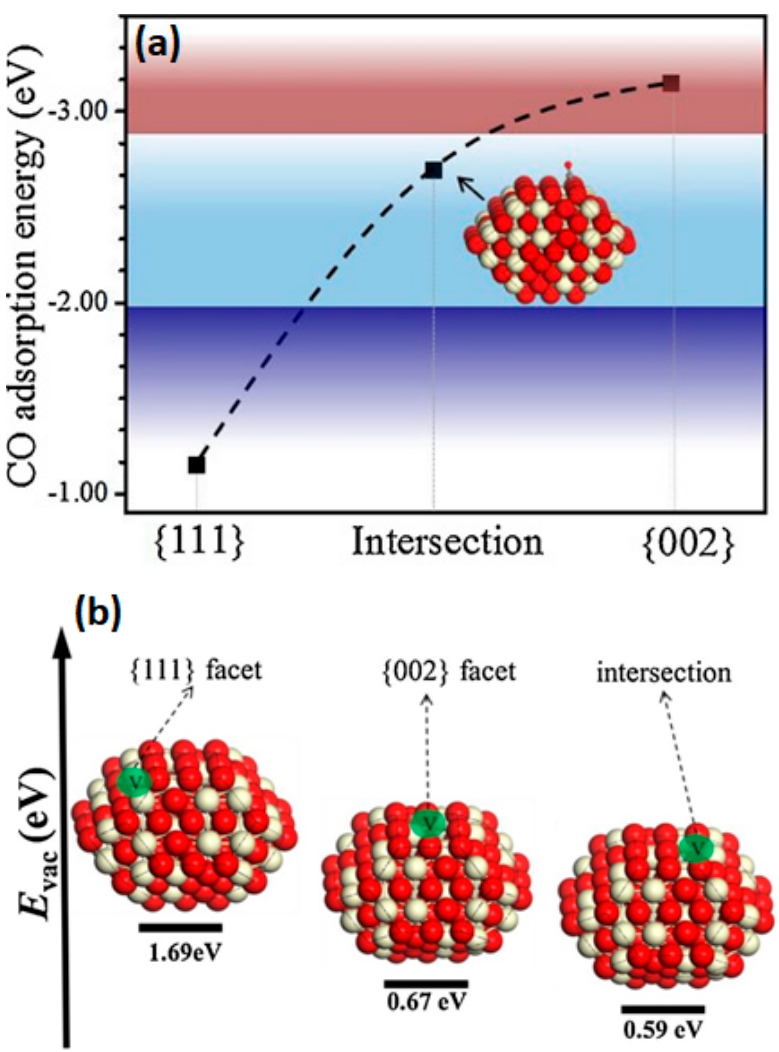
Figure 18. ( a ) DFT-calculated adsorption energy for molecularly adsorbed CO on {111}, {002} facets and their intersection sites of a Ce 60 O 120 cluster obtained, ( b ) Models of the optimized geometries of Ce 60 O 119 with an oxygen vacancy in the highlighted positions: {111}, {002} facets and their intersection, and values of oxygen vacancy formation energy (E vac ) below models. (Color code: O in red, Ce in grey, oxygen vacancy in the highlighted circle labeled “V”). Reproduced with permission from Reference [116]. Copyright © 2018, Elsevier.